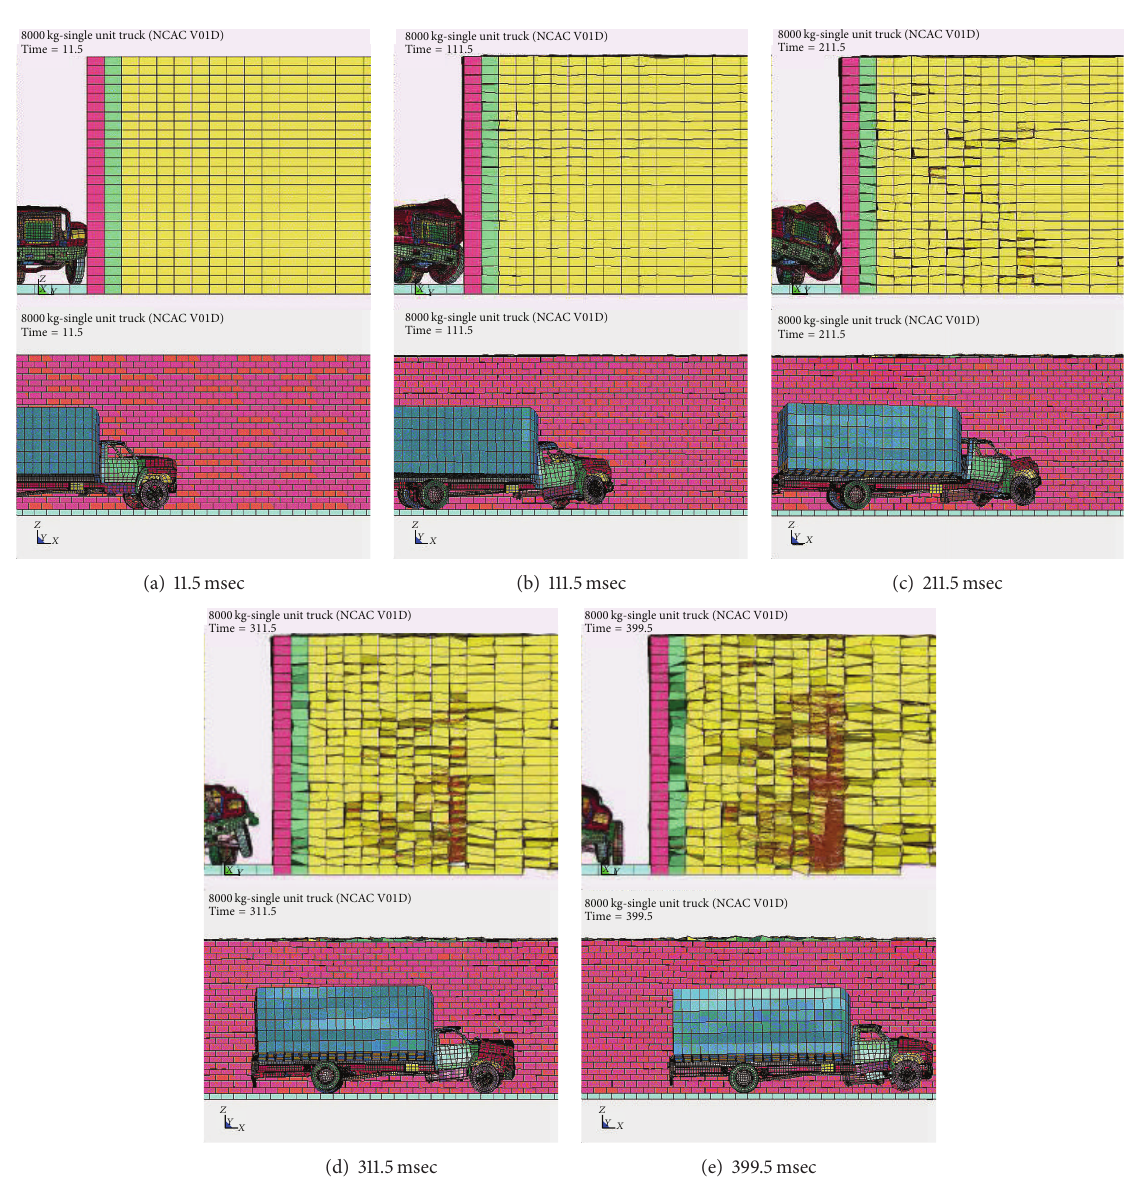
Figure 5: Behavior of reinforced retaining wall during vehicle